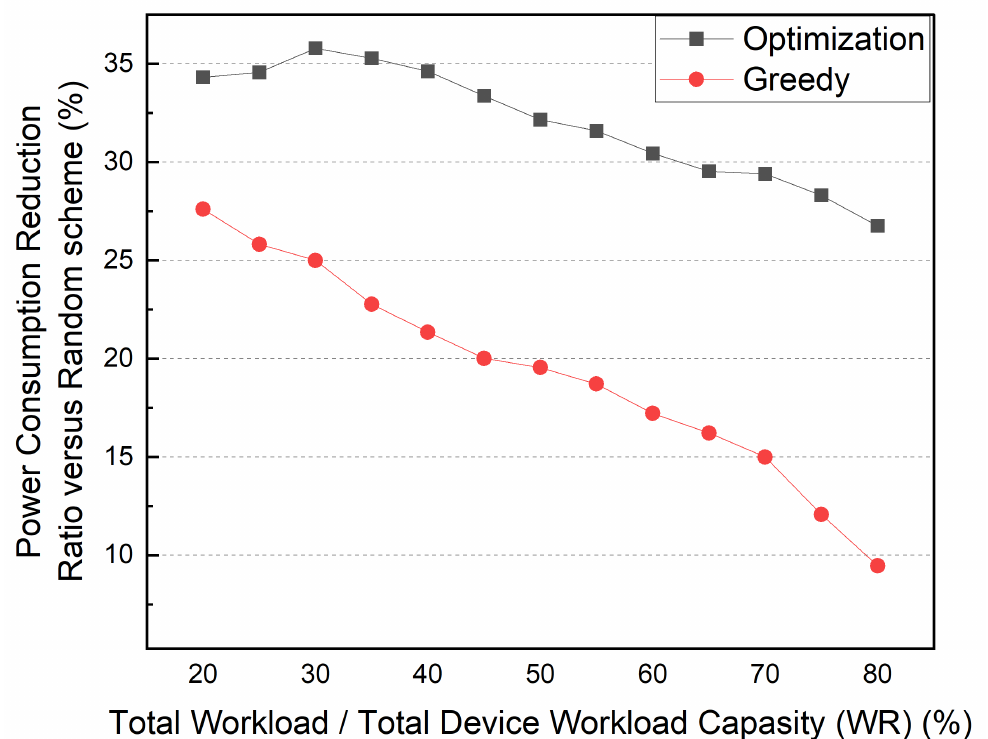
Figure 22. Power consumption comparison according to